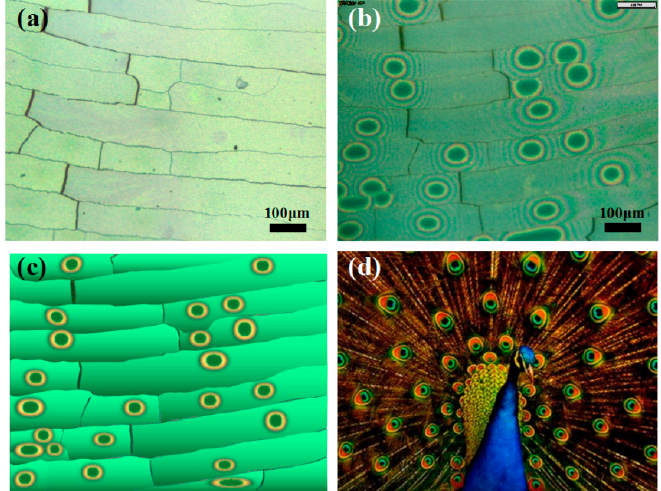
Figure 1. Optical microscope images of as-prepared sample. ( a ) Front side of the sample; ( b ) Back side of the sample; ( c ) Scheme for the as formed sample; ( d ) Eyes pattern of peacock tail feather (The picture was obtained from [25]). The front side of the sample shows crossed crack, while the back side of the sample shows plenty of the eyes pattern similar to the peacock tail